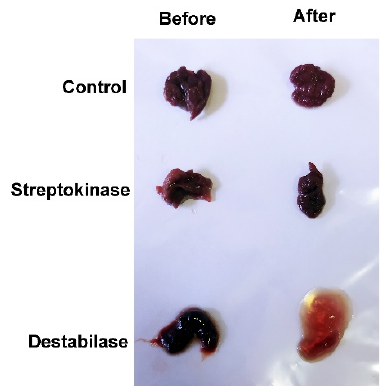
Figure 4. Blood clot morphology change photograph. The dry blood clot was divided into parts, incubated with destabilase (400 μ g/mL), streptokinase (U/mL), and control buffer for 24 h, and lyophilized. Then, three parts were incubated in 2% acetic acid solution for the next 24 h, and additional three parts were rehydrated in 2% acetic acid for 10 min prior to taking a photograph.